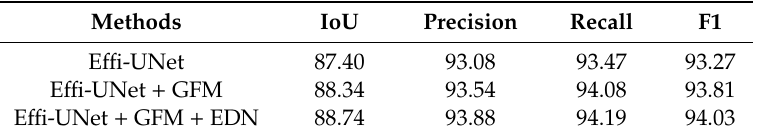
Table 2. Experimental results from successively improved models on the Shanghai distributed photovoltaic power station data set